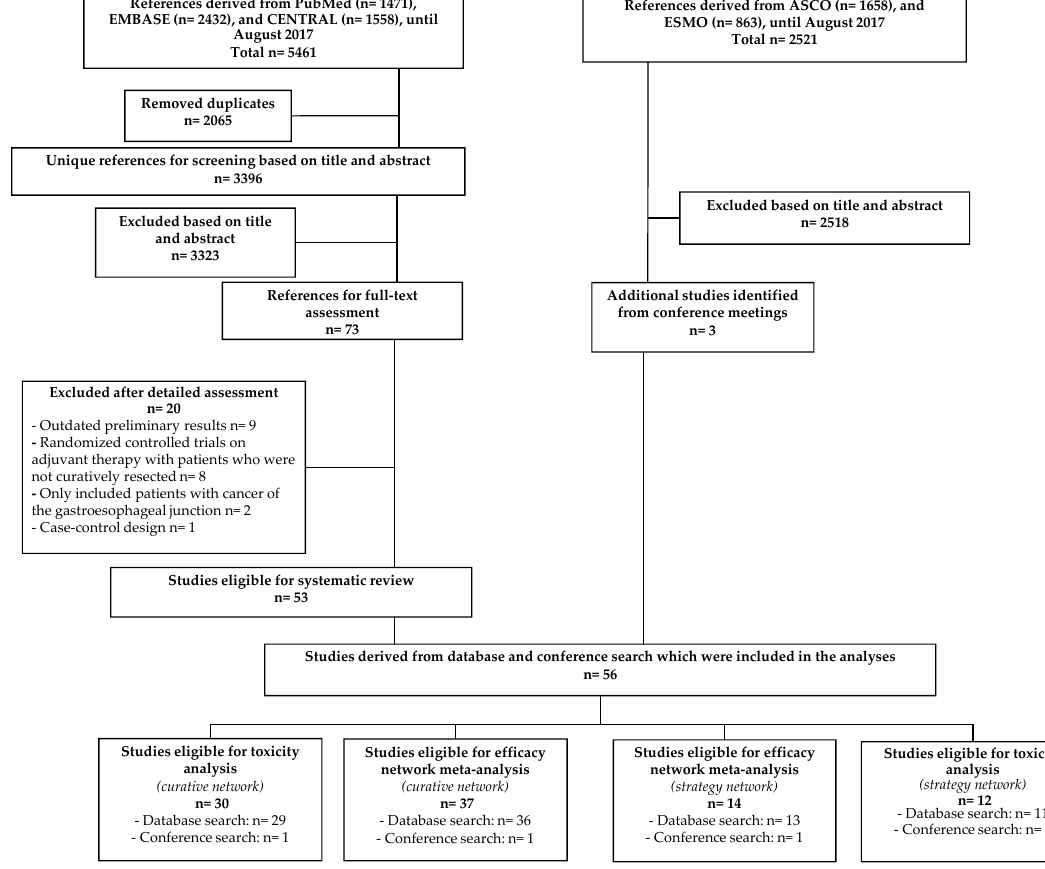
Figure 1. Flowchart of references derived from database search (left) and from conference search (right). Due to the absence of enough data to calculate a hazard ratio for survival, three studies on different treatment strategies and two studies on adjuvant therapy after curative resection were only eligible for the toxicity analyses. N = number of